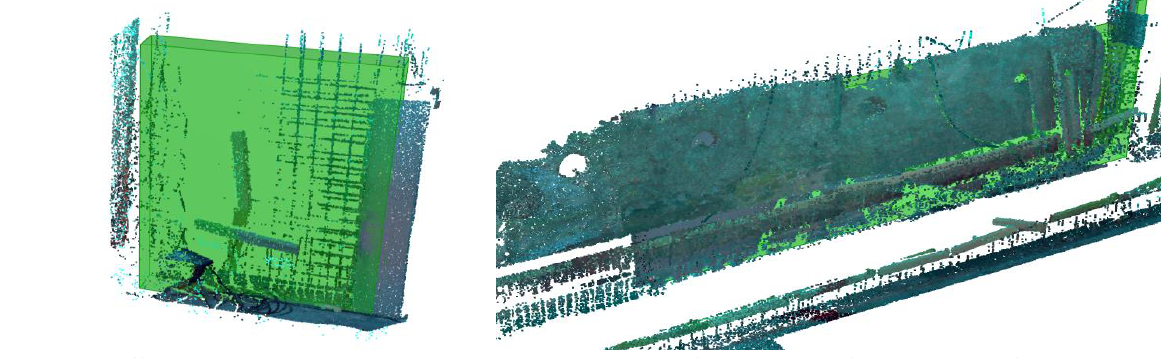
Figure 4e: The buffered point cloud extraction introduces noise especially in the vicinity of neighboring objects. Figure 4: Experimental results of the Percentage of Completion estimation of in-situ cast concrete walls in consecutive point clouds epochs of a construction